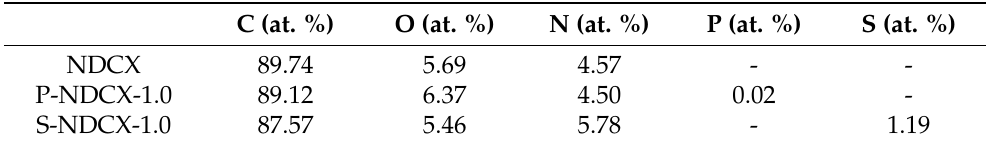
Table 2. Surface element percentage of NDCX, P-NDCX-1.0, and S-NDCX-1.0, detected from the XPS measurements.